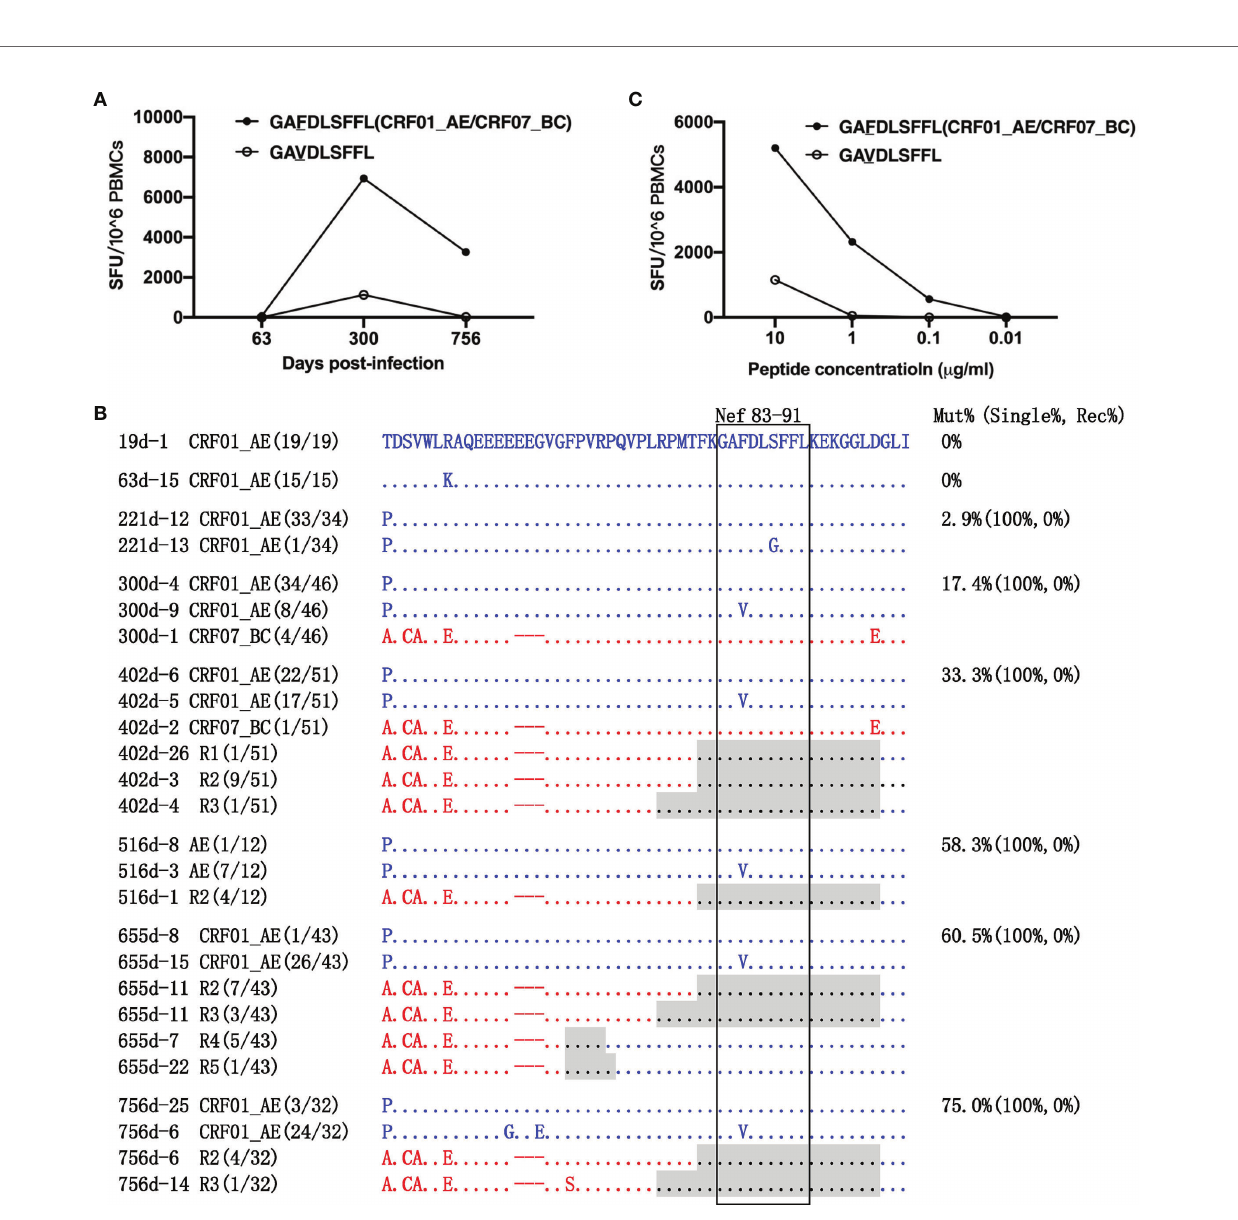
FIGURE 5 | Escape from GL9 epitope-speci fi c T-cell responses. (A) T-cell responses targeting the GL9 epitope and the F85V variant epitope were detected at 63, 300, and 756 days post-infection (dpi) by ELIspot. (B) The amino acid alignment of partial regions of the Nef protein covering the GL9 epitope and its fl anking regions at different time points. Sequences derived from the CRF01_AE strains are highlighted in blue. Those derived from the CRF07_BC strains are highlighted in red. The recombination breakpoints are shaded gray. The amino acids of the GL9 epitope are boxed in black. The number in parentheses indicates the number of clones with the reported sequence. The percentages of sequences with epitope mutation (Mut%) and the percentage of single (Single%) or recombinant sequences (Rec%) are listed. (C) Responses to various variants within the GL9 epitope were detected using peripheral blood mononuclear cells (PBMCs) at 756